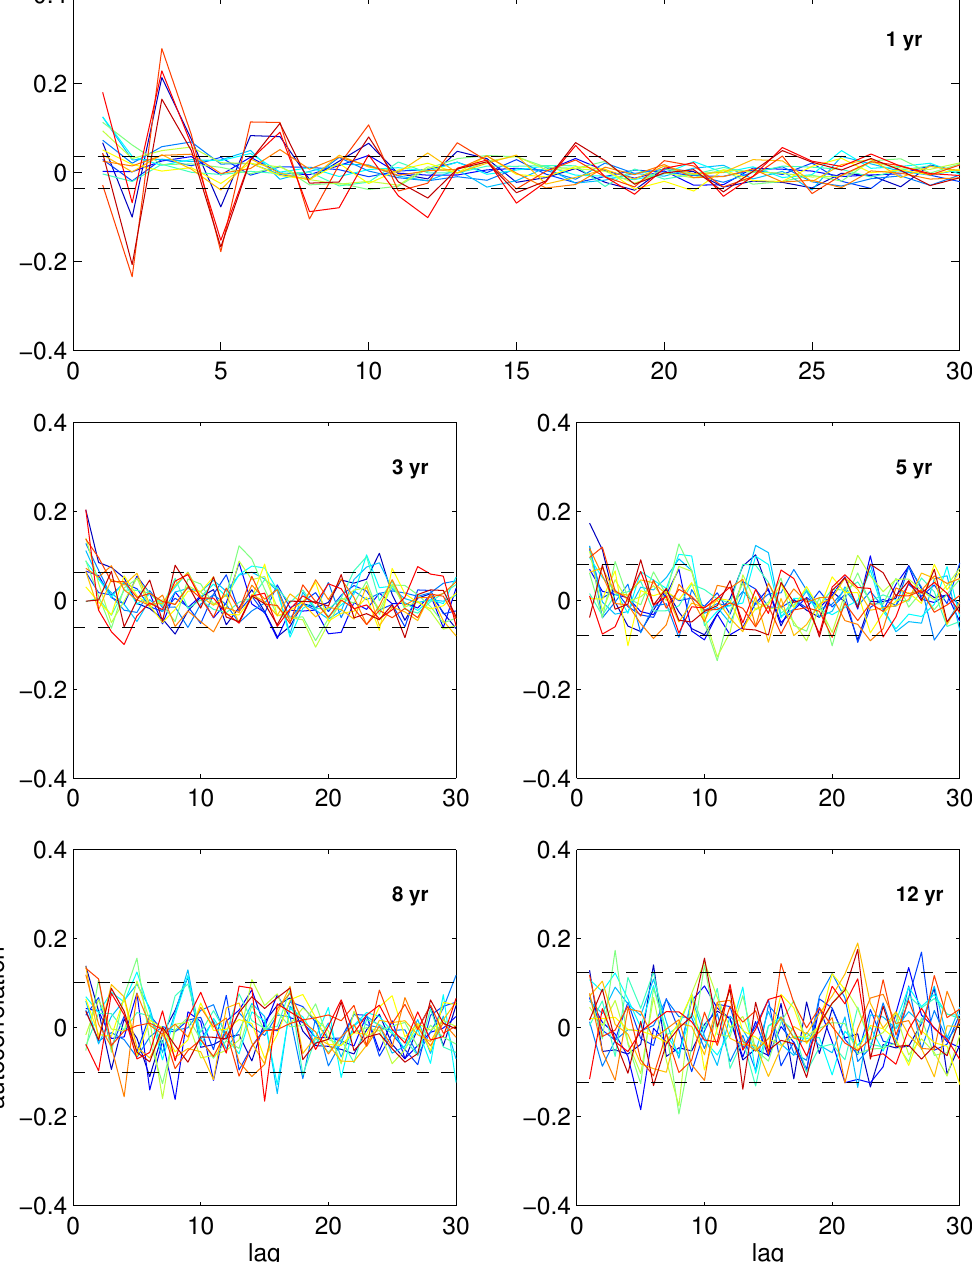
Figure 5. Estimated autocorrelation function for lags up to 30 in the 3000-year-long unforced control simulation, for time units of 1, 3, 5, 8 and 12 years. Two-sided 5% significance levels for a white noise process are shown with dashed lines. Data for each region, identified by the colour legend to the right in Fig. 4, are for the season as specified in Table